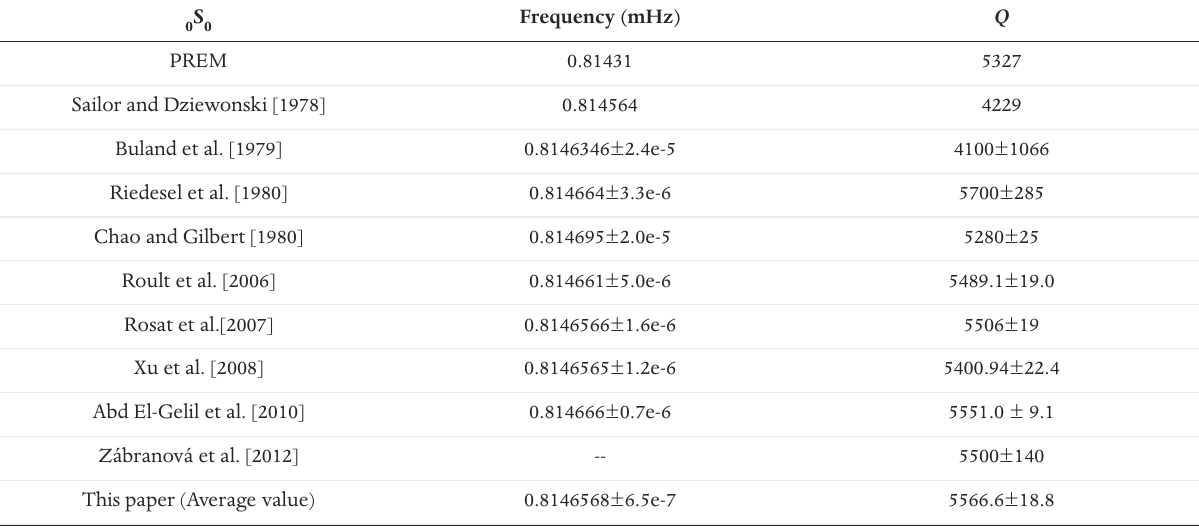
S , and the model predictions and observations of previous 0 0